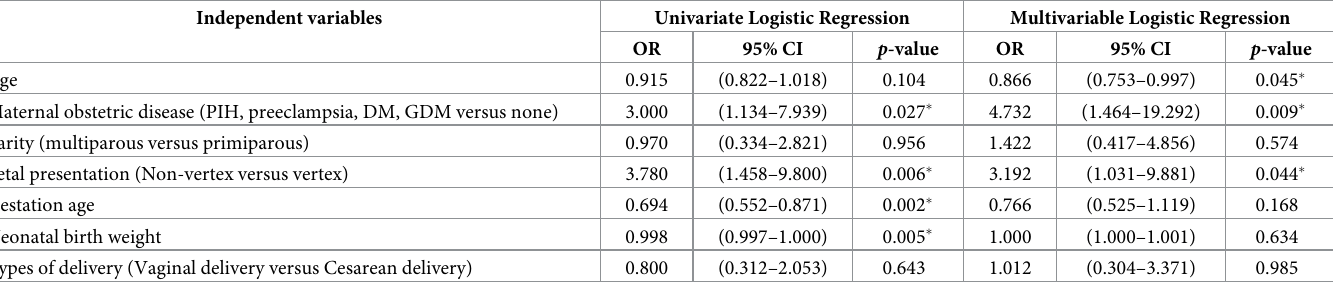
Table 3. Logistic regression analyses for determinants of low Apgar Score a